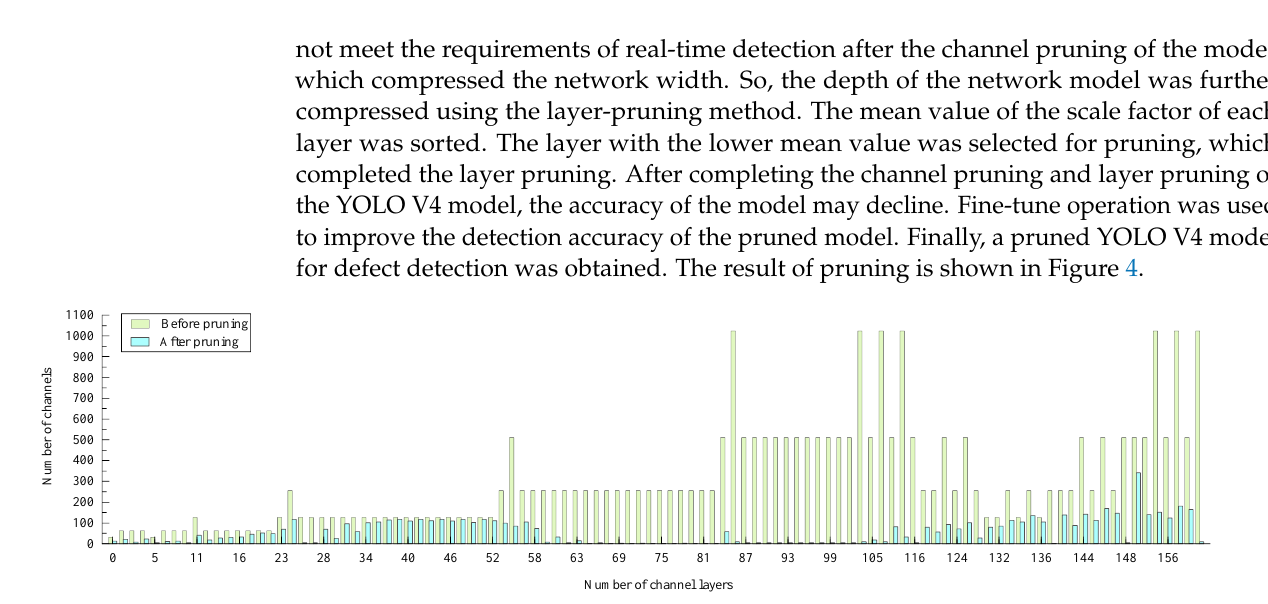
Figure 4. The channel changes of each layer of YOLO V4 model before and after pruning. Pruned YOLO V4 network could accurately locate the location of apple defects and identify the apple stem/calyx. For the defection of regions identified by the pruned YOLO V4 network, the corresponding location information of each defect region was compared with the binary image I B generated by BiSeNet V2 network. For the position where the gray value Bv was in the defect area determined by pruned YOLO V4 network, it was determined as the defect area. Finally, the defect region in apple image was segmented accurately by combining BiSeNet V2 network and pruned YOLO V4 network.